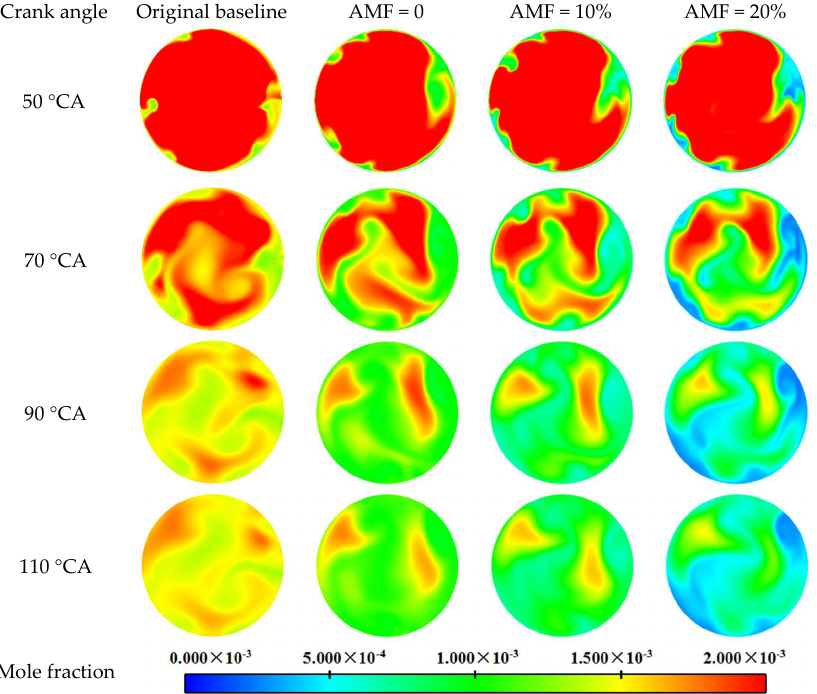
Figure 9. NO evolution with variation of AMF (DI timing = −105 °CA).